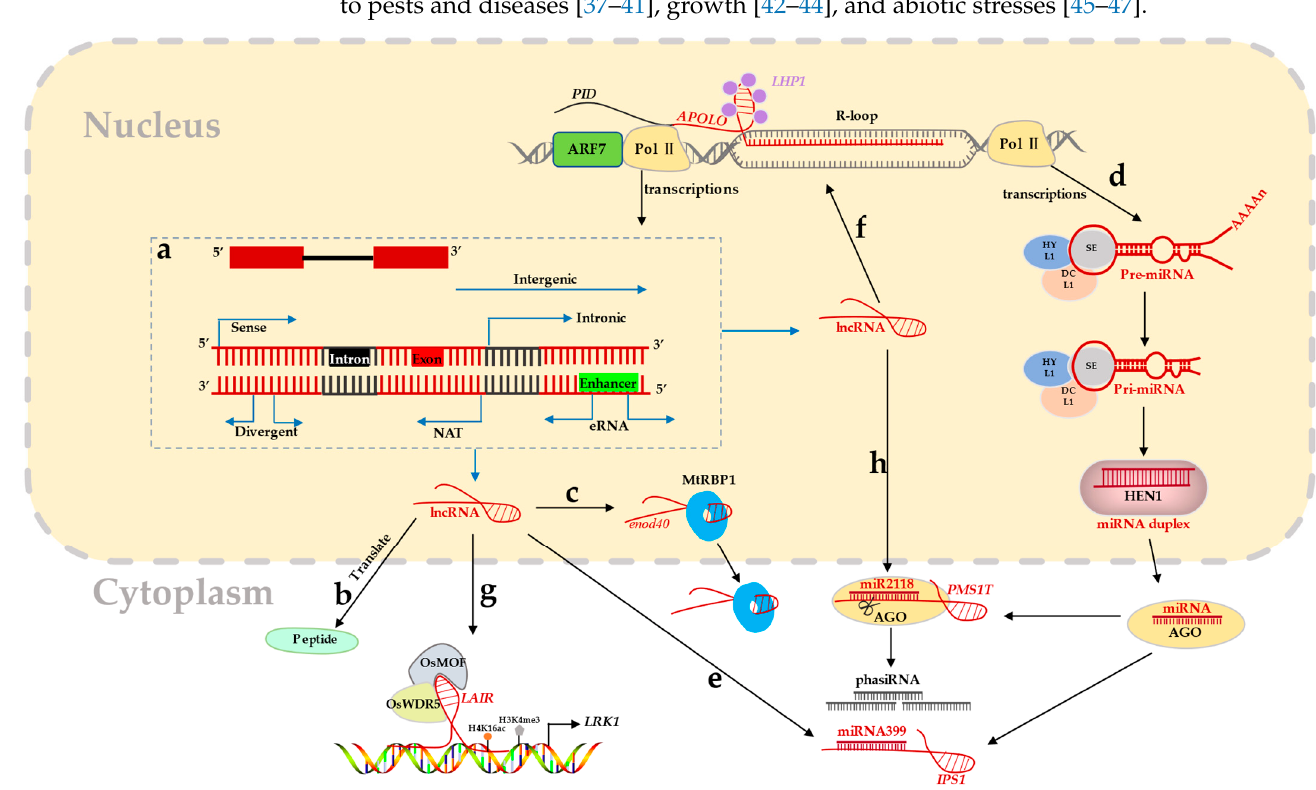
Figure 1. The source and mechanism of lncRNA. ( a ) The lncRNAs are transcribed inside the nucleus from the genome by Pol II and the arrows represent different types of lncRNAs. ( b ) lncRNA can encode small peptides [27]. ( c ) lncRNA enod40 directly binds to MtRBP1 ( Medicago truncatula RNA binding protein 1) in root nodules to relocate MtRBP1 from the nuclear speckle of plant cells to the cytoplasmic granules [48]. ( d ) miRNA is transcribed by RNA Pol II. First, the pre-miRNA (precursor miRNA) is processed into miRNA duplex by DCL1 (Dicer-like protein 1), and then the miRNA duplex is processed into single stranded miRNA by HEN1 (HUA ENHANCER 1). The mature miRNA strand is combined with AGO (Argonaute) to carry out post-transcriptional gene regulation through target cutting or inhibition [49]. ( e ) lncRNA IPS1 ( INDUCED BY PHOSPHATE STARVATION1 ) can competitively bind to miRNA399 to upregulate the expression level of PHO2 and maintain phosphate homeostasis in Arabidopsis [50]. ( f ) Transcription of lncRNA APOLO ( AUXIN-REGULATED PROMOTER LOOP ) and PID is directly activated by ARF7, while APOLO binds to its adjacent site PID to form an R-loop and recruits LHP1 to change chromatin conformation. APOLO can regulate auxin-related response genes to coordinate auxin distribution and lateral root formation [51]. ( g ) LAIR ( LRK Antisense Intergenic RNA ) is an inverted NAT of LRK (leucine-rich repeat receptor kinase), which can directly interact with the LRK1 genomic region and act as a scaffold to recruit OsMOF or OsWDR5 to deposit H4K16ac or H3K4me3, respectively, resulting in up-regulation of LRK1 expression and increased grain yields [52]. ( h ) lncRNAs PMS1T ( PHOTOPERIOD-SENSITIVE GENIC MALE STERILITY T ) and miR2118 combine with Pms1 ( photoperiod-sensitive genic male sterility 1 ) transcript PMS1T , which can be recognized by miR2118 and cut to form a string of 21-nt miRNAs. These plant-specific miRNAs are called phasiRNA (phased siRNA), which regulates the fertility of rice [53].